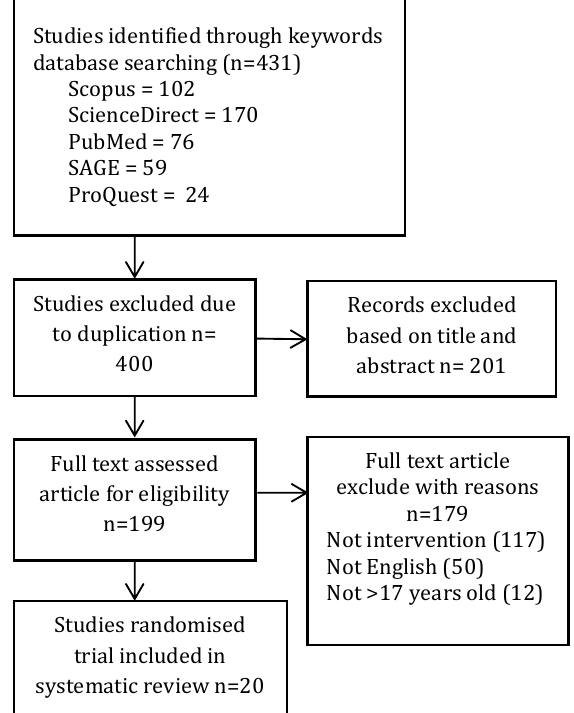
Figure 1. Flow diagram